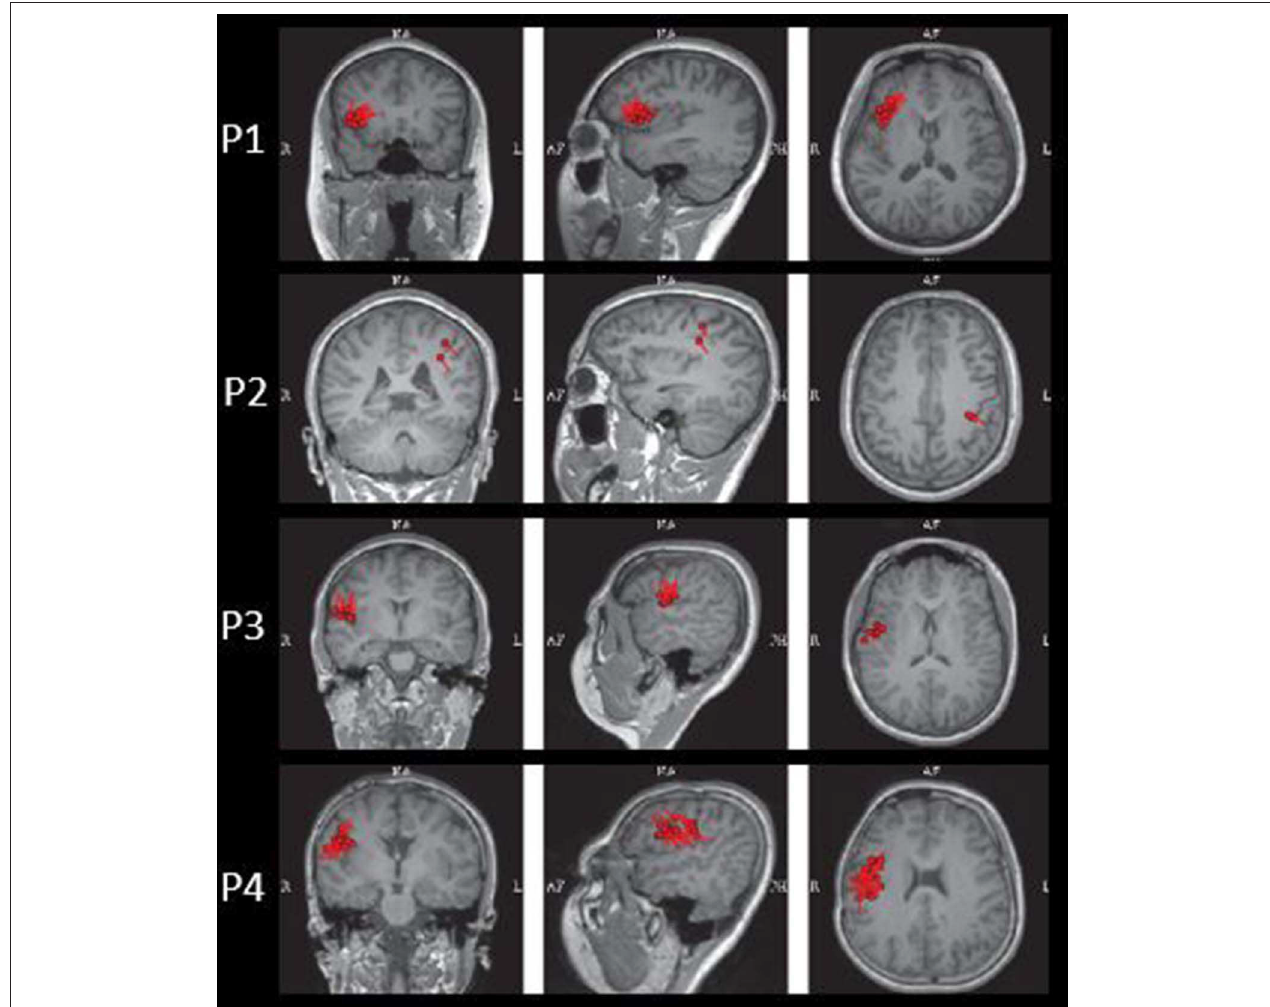
FIGURE 1 | The MEG results of Patient 1–4 in coronal, sagittal, and axial images.